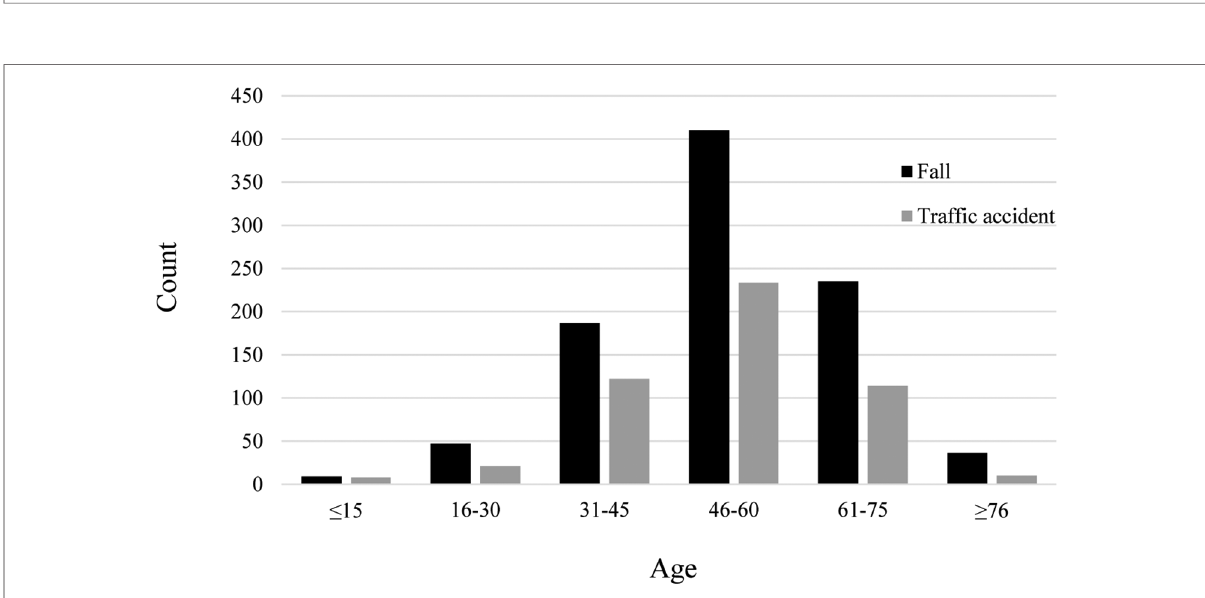
FIGURE 3 High-risk age group of the top two